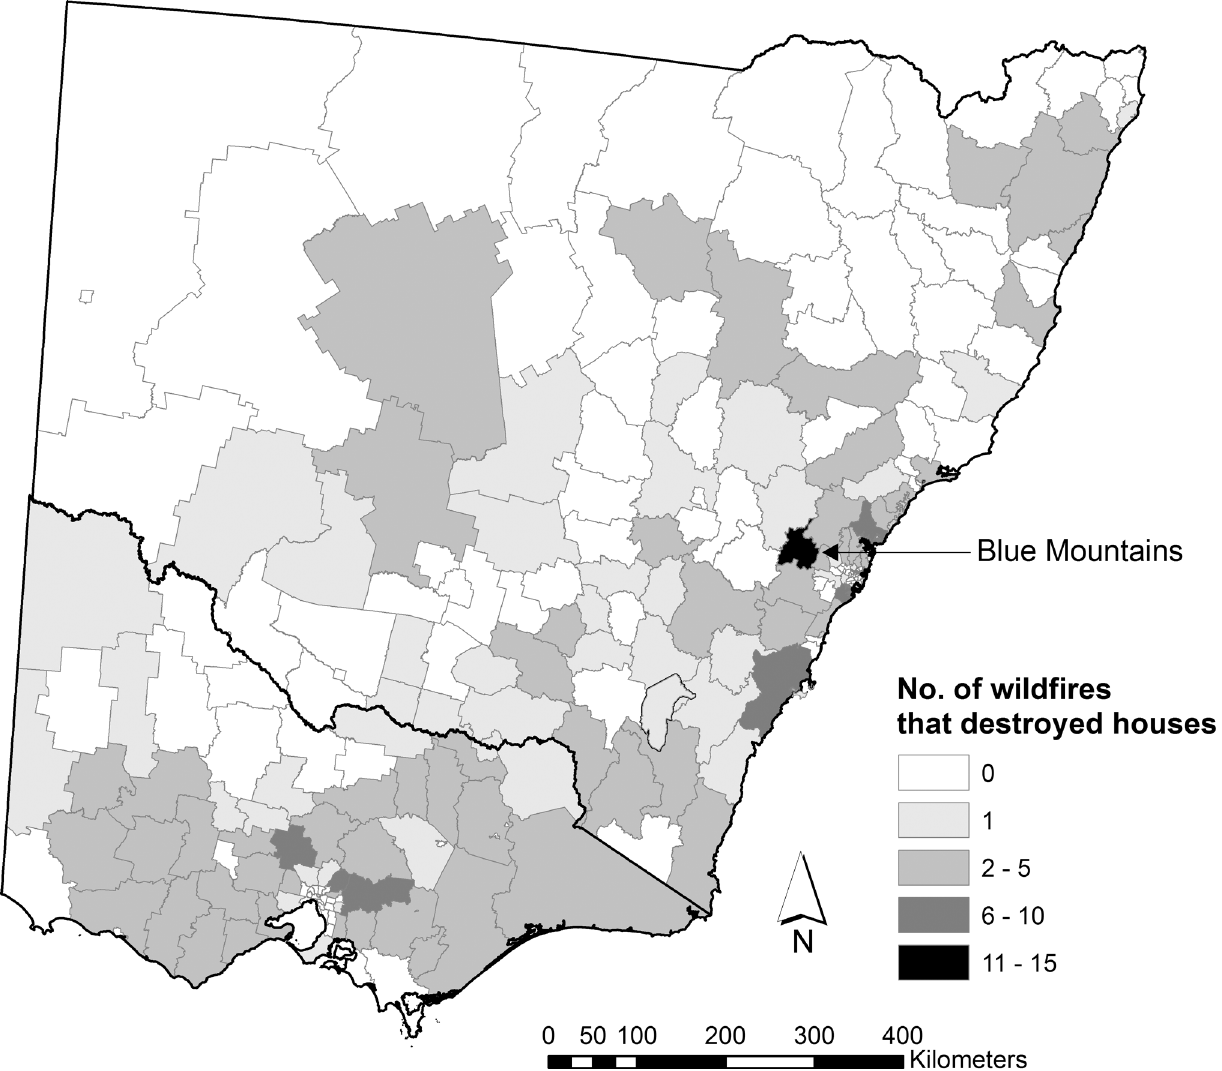
Fig 2. The number of wildfires that destroyed houses from 1951 to 2015 by local government area. Developed using Administrative Boundaries produced by PSMA Australia Limited licensed by the Commonwealth of Australia under Creative Commons Attribution 4.0 International licence (CC BY